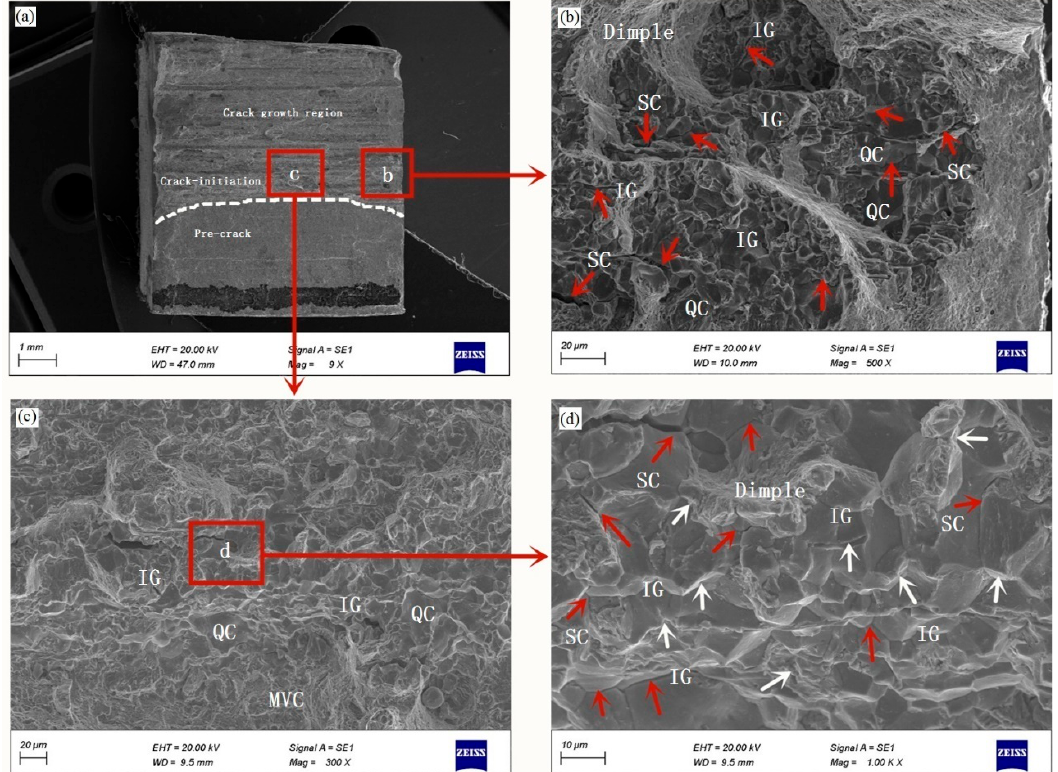
Figure 6. SEM images of the fracture surface of specimen charged for 36 h, and ( a ) overview of the fracture surface; ( b , c ) High magnification SEM images of the indicated region in image ( a ); ( d ) High magnification SEM image of the indicated region in image ( c ); (Red arrowheads indicate secondary cracks (SC) and white arrowheads indicate tear ridges). QC: quasi-cleavage; IG: intergranular fracture; MVC: microvoid coalescence.